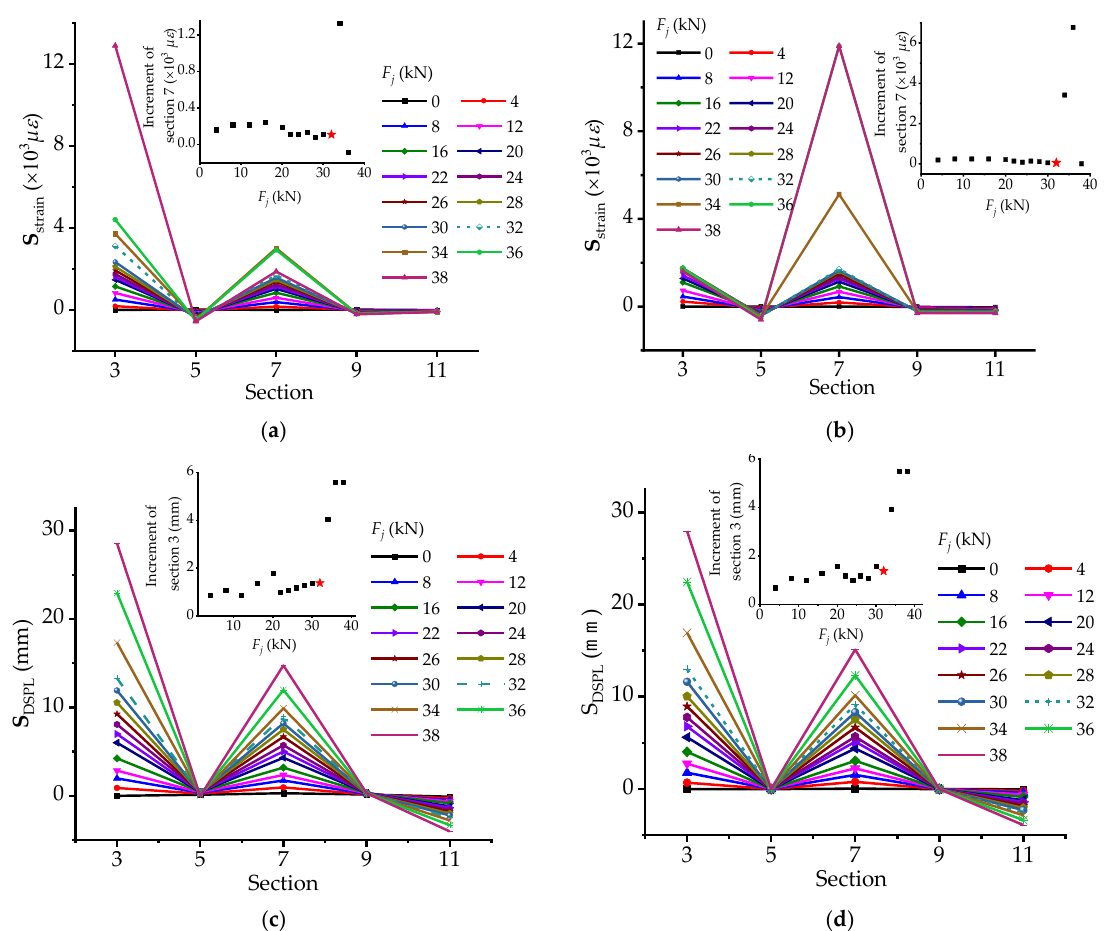
Figure 8. The changing features of strain-based and DSPL-based stressing state modes for cross sections: ( a ) Strain-based stressing state mode for the OS; ( b ) strain-based stressing state mode for the IS; ( c ) DSPL-based stressing state mode for the OS; and ( d ) DSPL-based stressing state mode for the MS.